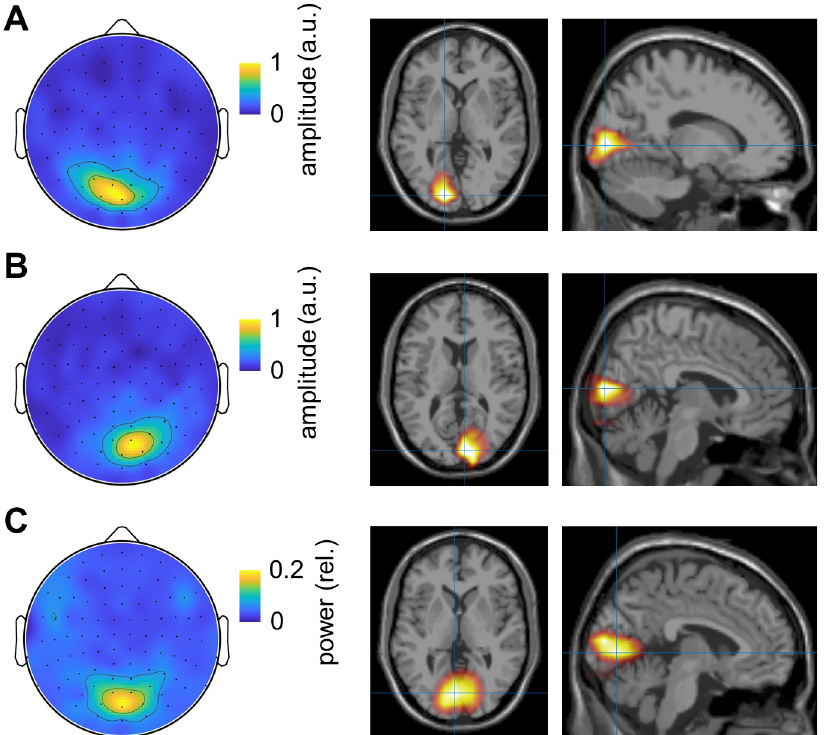
Fig 4. Topographies and source modelling of the gamma echo and induced gamma oscillations. (A) The topography and the source modelling (LCMV beamformer) of the peak amplitude of the gamma echo (0.04–0.08 s) for the right flickering stimuli. (B) Same as (A) but for left flickering stimuli. (C) The topography and source modelling of the power (DICS beamformer) of the induced gamma oscillations within range 40–100 Hz.